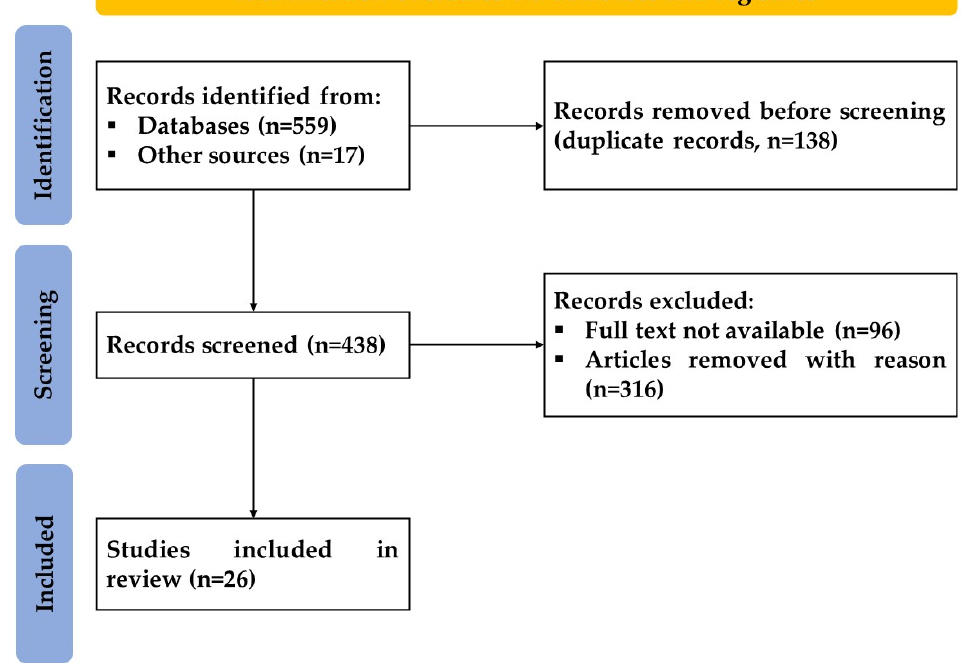
Figure 1. A PRISMA flow diagram outlining the record identification and selection process.